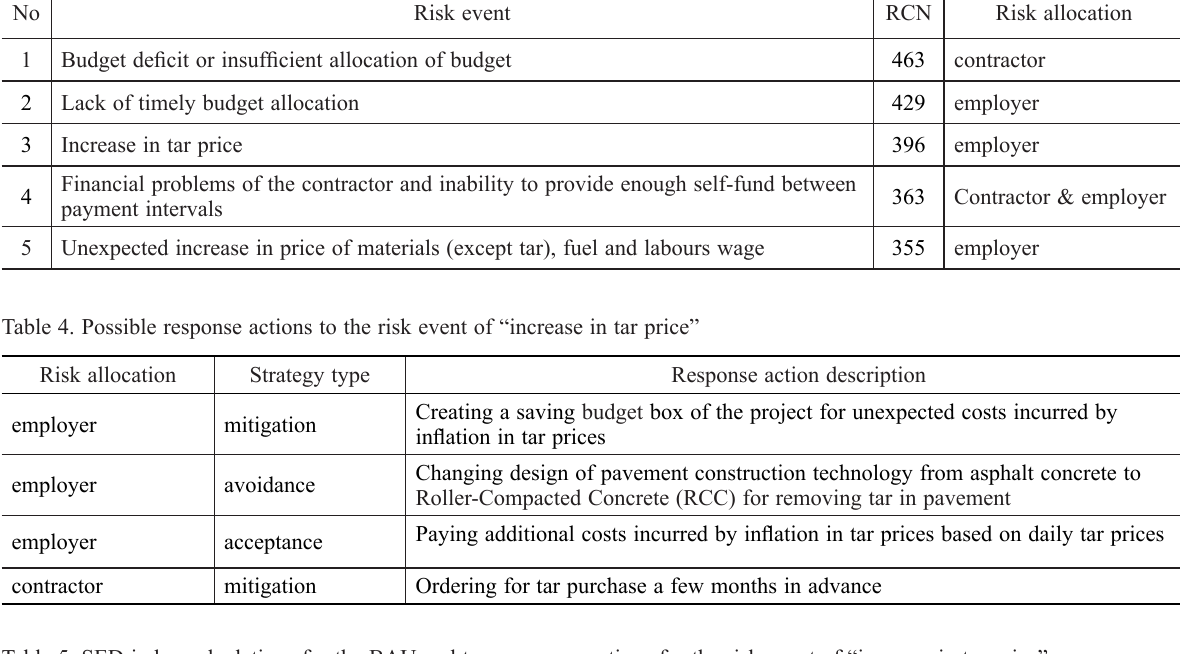
Risk allocationRCNRisk eventNo